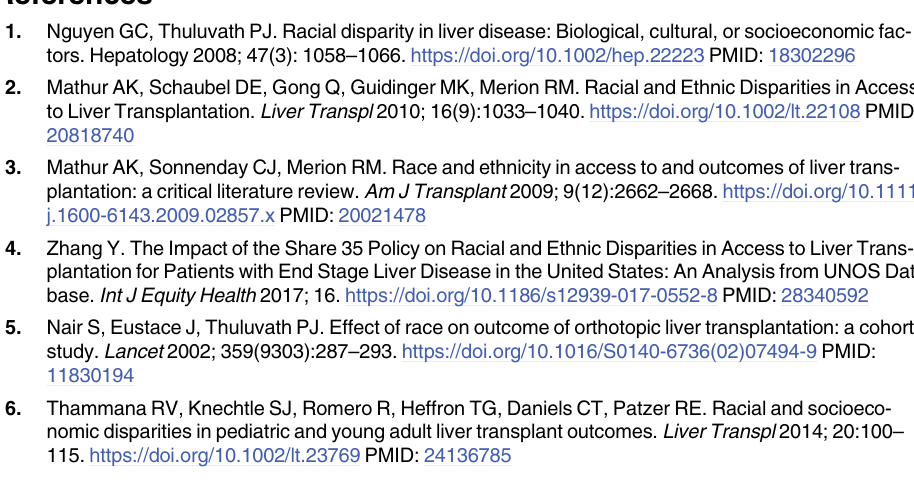
S1 Table. Causes of death after liver transplant. S2 Table. Patients’ characteristics comparison between Hispanics and Non-Hispanics in matched